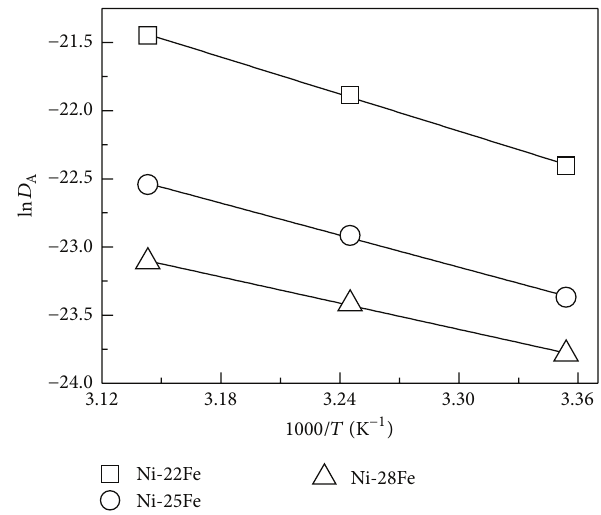
Figure 9: ln 𝐷 𝐴 versus 1/ 𝑇 for the ordered Ni 3 Fe alloys with various